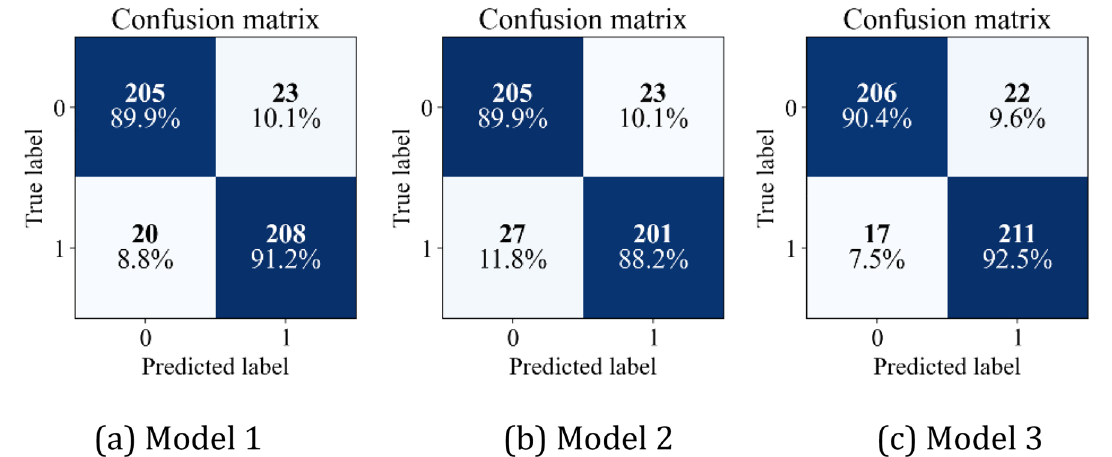
Figure 11. Confusion matrixes depicting the precision index on simulated site